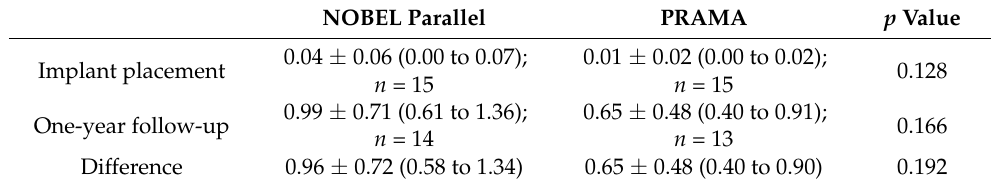
Table 5. Mean marginal bone levels between groups. NOBEL Parallel